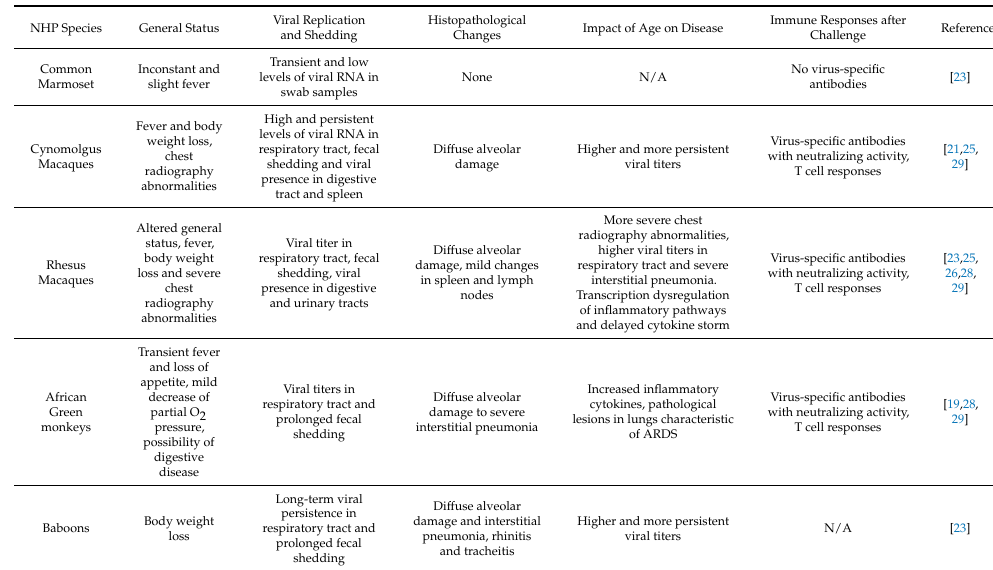
Table 1. Characteristics of SARS-CoV-2 infection in different non-human primate